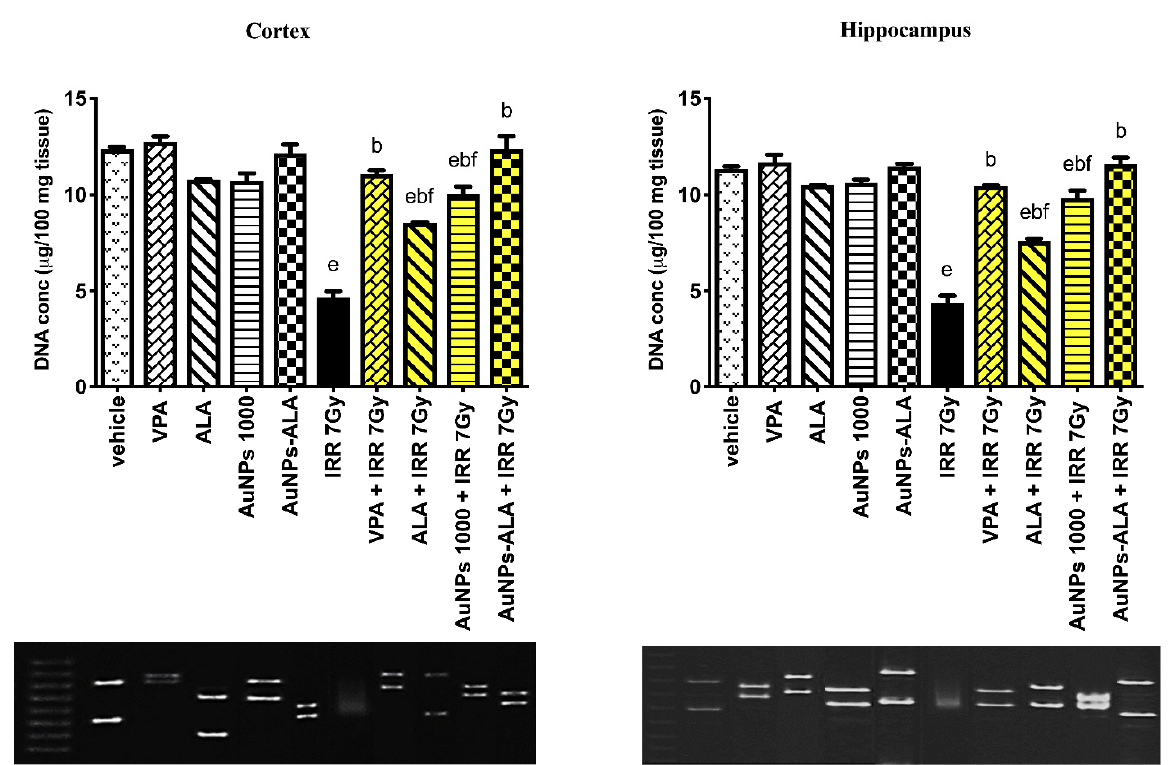
Figure 10. Effect of single oral administration of AuNPs-ALA mixture on DNA fragmentation in cortical and hippocampal tissues of 7Gy-irradiated rats. Every bar with a vertical line displays the mean ± S.E ( n = 6). e vs. vehicle, b vs. IRR 7Gy, f vs. AuNPs-ALA + IRR 7Gy; p <